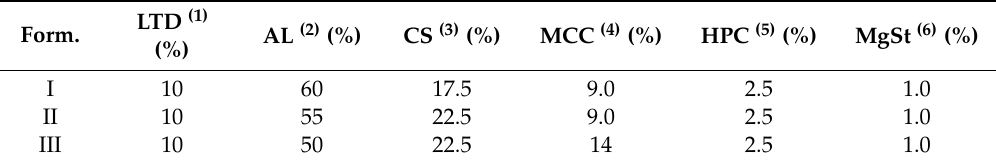
Table 1. Test formulations of tablets.